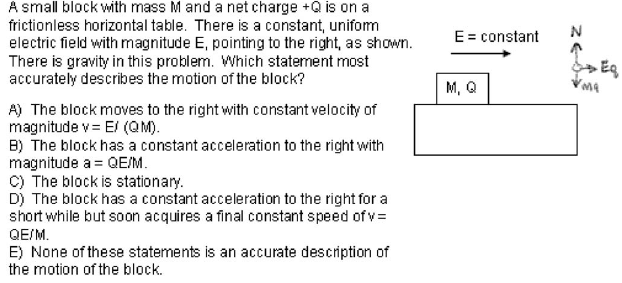
FIG. 3. Multiple representation problem from a Univeristy of Colorado exam. The free-body diagram is not part of the problem statement.